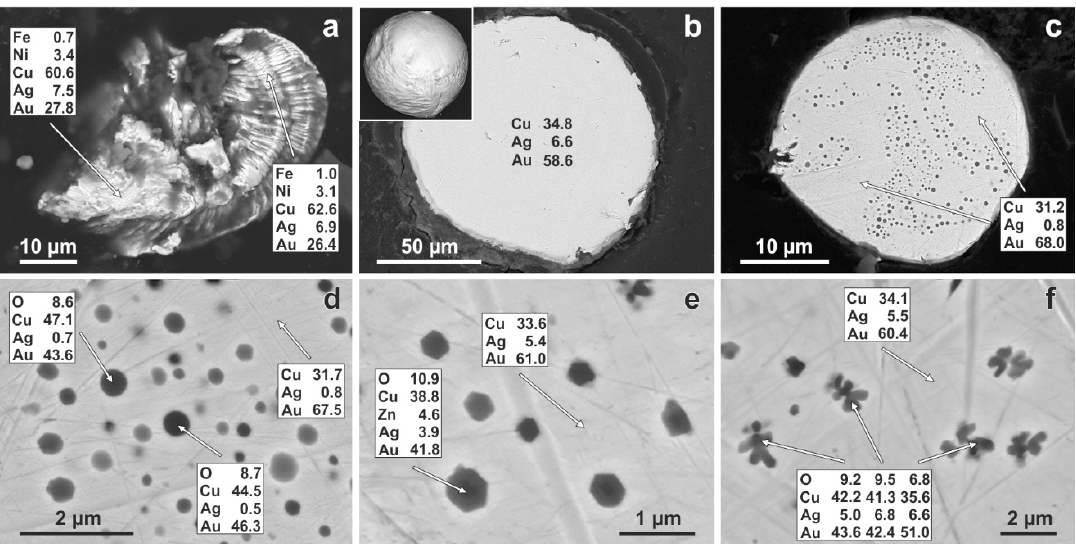
Figure 15. Shapeless gold-bearing particle ( a ) and spherules ( b – f ) in hematite-bearing tuff from the Kaylan deposit: ( b )— homogeneous spherule; ( c )—spherule with spiral-shaped arrays of Cu-rich inclusions; ( d – e )—rounded ( d ), faceted ( e ) and dendritic ( f ) Cu-rich inclusions.